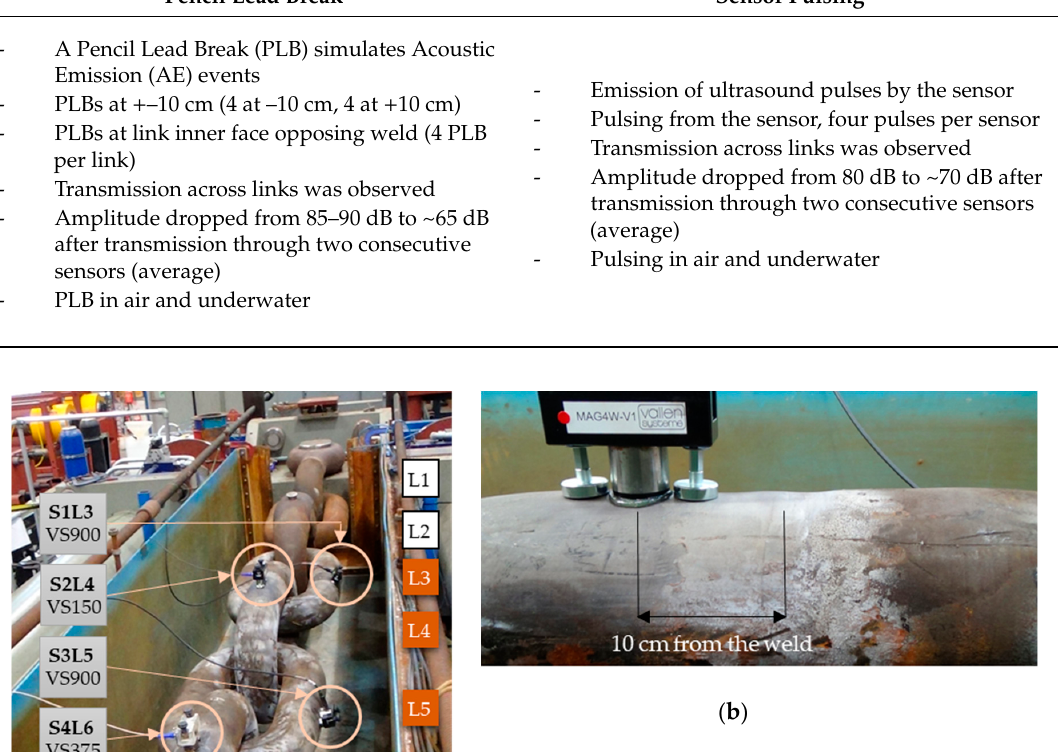
Table 1. Signals reproducibility verification.